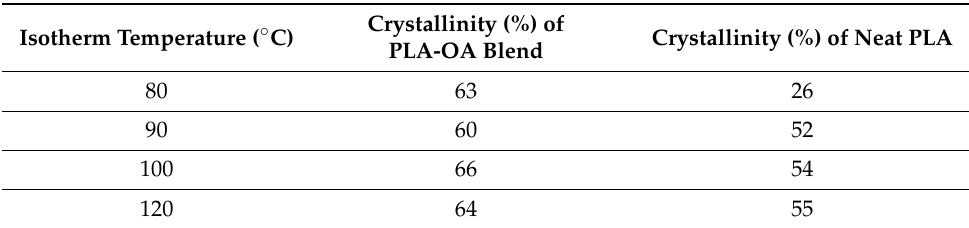
Table 2. Degree of crystallinity of PLA-OA blend and neat PLA as determined from the DSC melting curves.